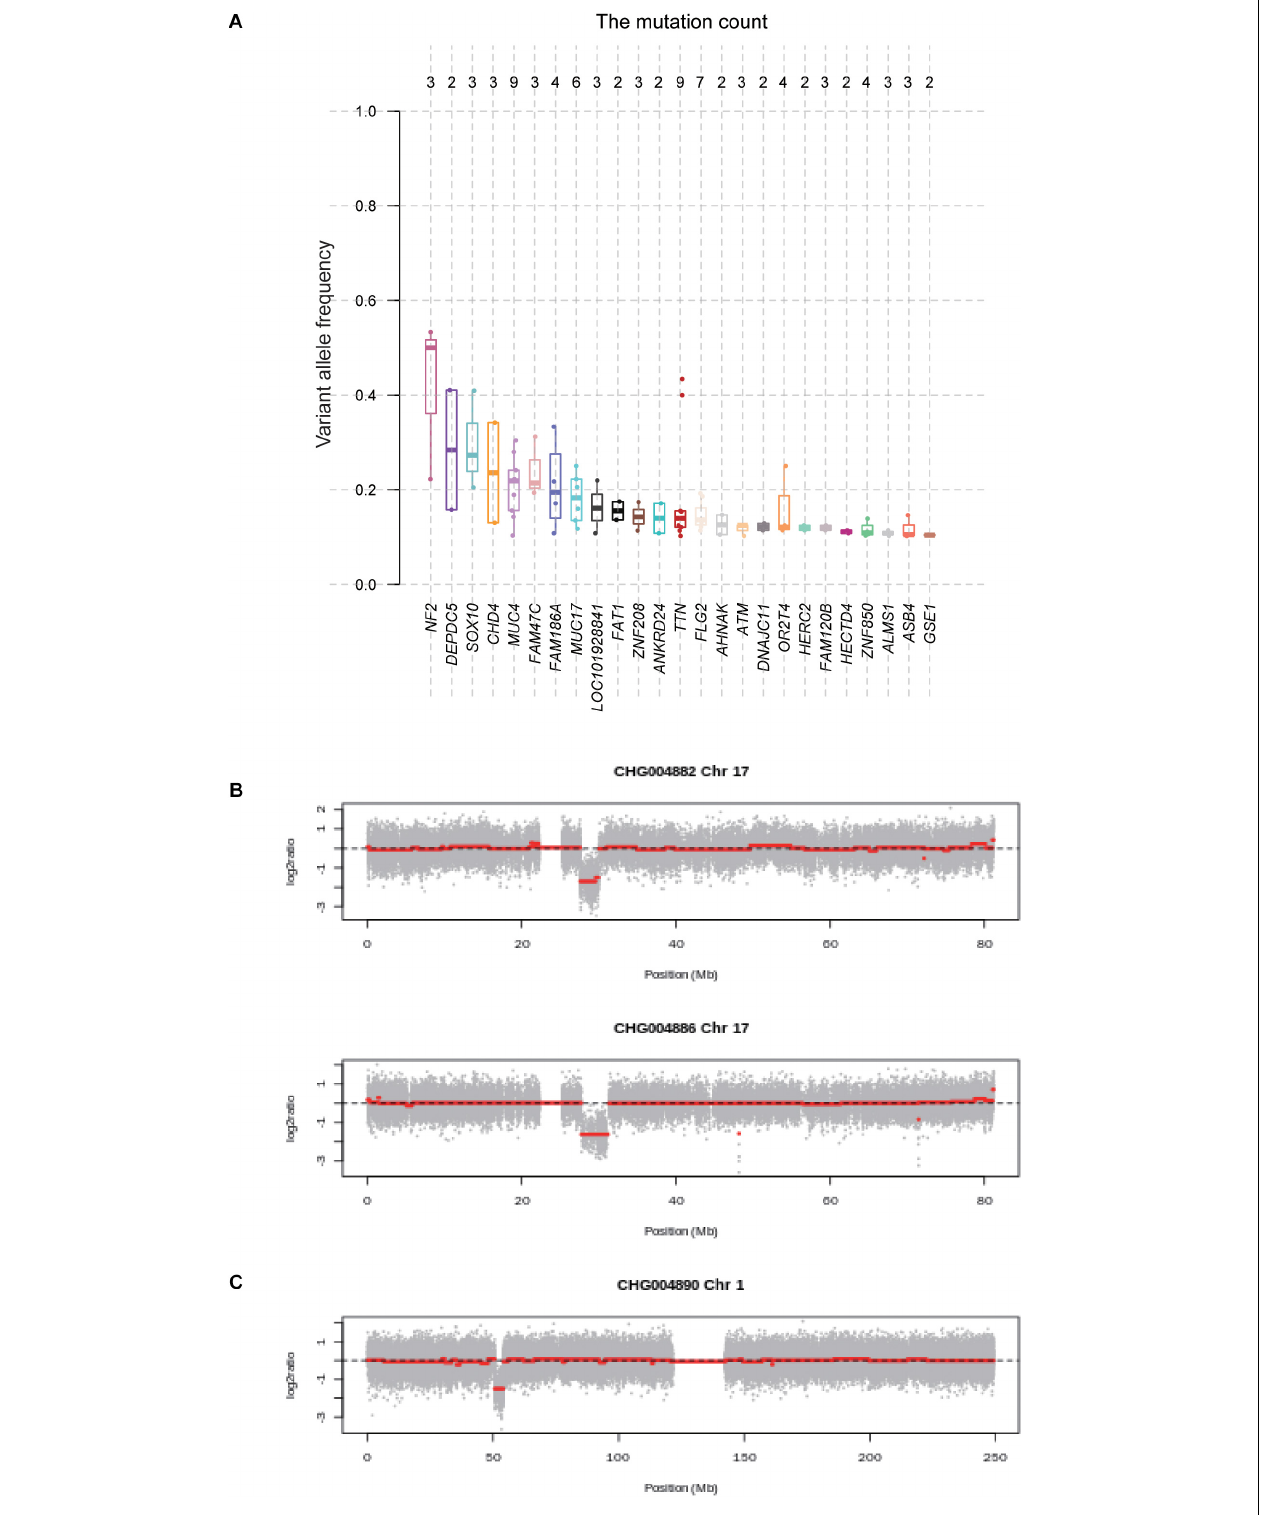
FIGURE 3 | The variant allele frequency (VAF) of the genes mutated in spinal schwannomas. (A) The numbers on the top represent the number of mutations. The genes are ordered by the median of VAF across the mutations. (B,C) The log2 copy number ratio of chromosomes 17 and 1 in the spinal schwannoma samples.